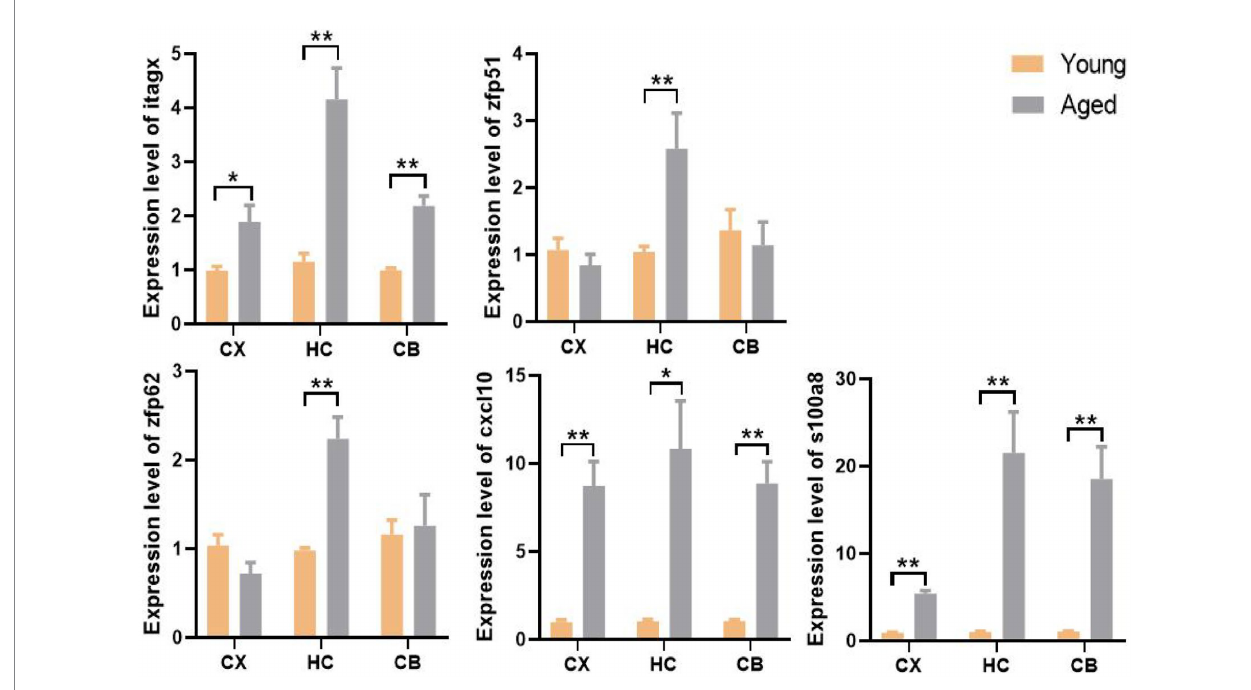
FIGURE 9 The expression level and regional specificity of the hub genes and S100a8 in mice (Measured by RT-qPCR method). Sample size (Young and aged samples account for half of each panel): Itgax (CX: n = 32, HC: n = 14. CB: n = 32); Zfp51 (CX: n = 14, HC: n = 32. CB: n = 14); Zfp62 (CX: n = 14, HC: n = 32. CB: n = 14); Cxcl10 (CX: n = 14, HC: n = 14. CB: n = 32); S100a8 (CX: n = 32, HC: n = 32. CB: n = 32); p -values of Itgax of CX, Zfp51 of HC, S100a8 of HC and CB are calculated with Wilcoxon rank-sum test. p -value of other panel are calculated with t -test. Results are expressed as mean ± SEM. CX,